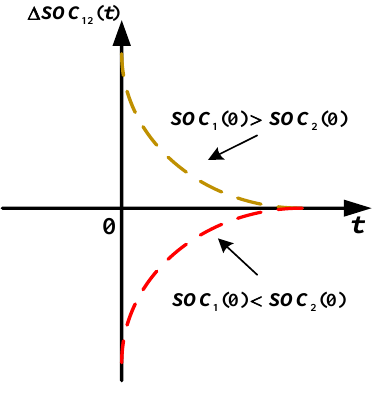
Figure 5. Δ𝑆𝑂𝐶 12 (𝑡) convergence curve.